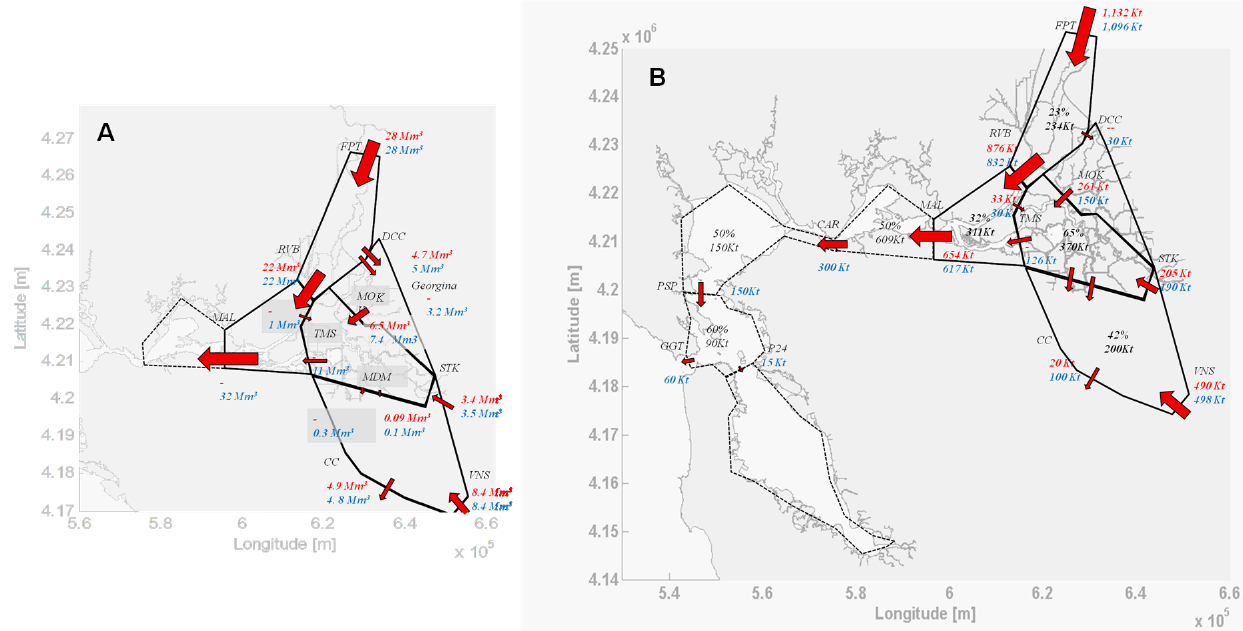
Figure 8. Water discharge (a) and sediment flux (b) pathway models. The arrows represent the water (a) and sediment (b) fluxes through the cross sections. Area of the arrow is proportional to the flux. Fluxes from data are in red and from the model are in blue. Inside each polygon are the trapping efficiency and deposition volume for the area. The bay portion is dashed because the model is 2-D and 3-D processes occur in that